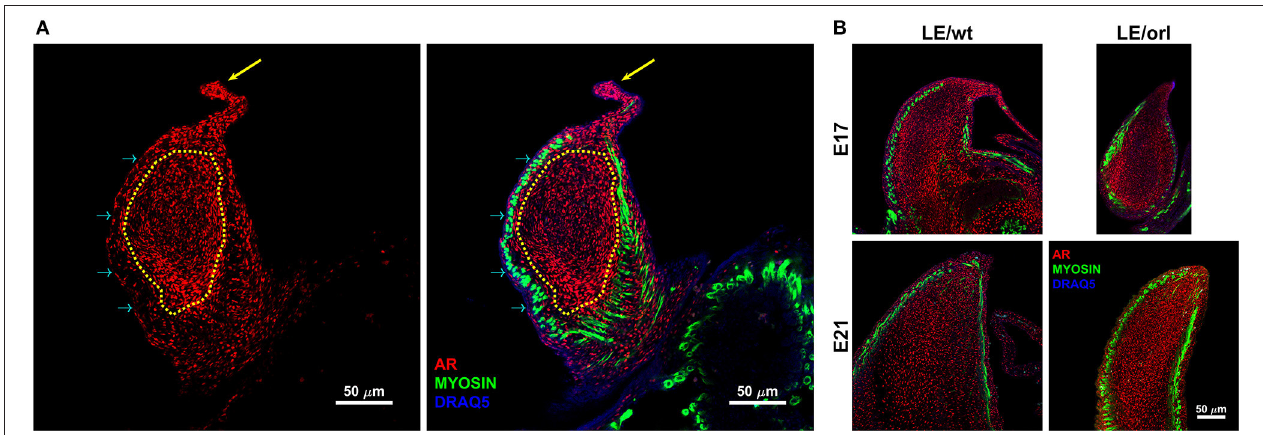
FIGURE 1 | Confocal images of the sagittal midportion of LE/wt gubernacula show androgen receptor (AR) and muscle expression defined by anti-AR (red) and anti-myosin heavy chain (green) immunofluorescent staining. Images are oriented in the longitudinal plane with the cord oriented superiorly. (A) Representative image of E17 LE/wt gubernaculum with localization of AR visible throughout the inner mesenchymal core (traced in yellow) and the gubernacular cord (yellow arrow). As noted in the merged image (second panel), nuclear localization (magenta) is strongly evident in the tip region and cord. However, myosin positive cells are negative for AR, several prominent examples highlighted by cyan arrows. (B) In E17 and E21 gubernacula isolated from LE/wt and LE/orl fetal rats, AR + cells are visible within the central mesenchyme and near the tip, which contains a previously described growth center. By E21, as the gubernaculum is starting to invert, areas of clearing with reduced AR + cell density appear